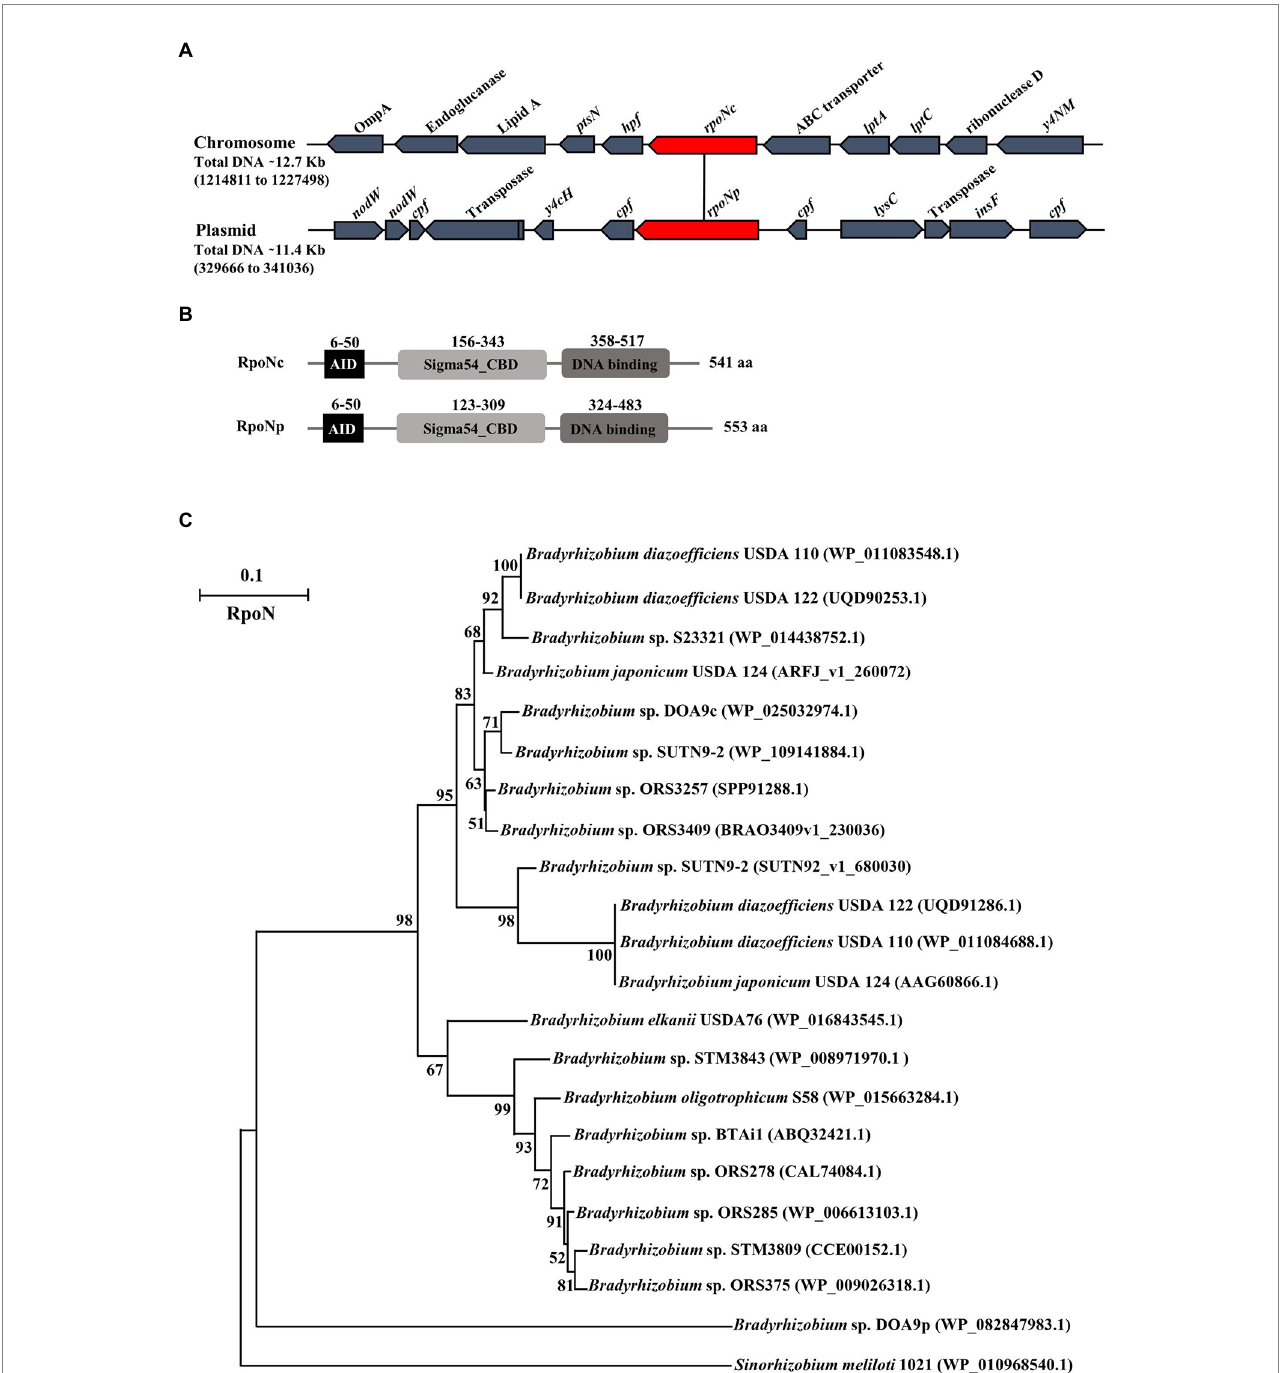
FIGURE 1 Diagram of the chromosomal and plasmid region containing rpoN in Bradyrhizobium sp. strain DOA9 (A) . Different protein domains present in chromosomal and plasmid encoded RpoN; AID (activator initiation domain), CBD (core binding domain), and DNA binding domain (B) . Phylogenetic analysis of RpoN from various Bradyrhizobium strains using the maximum-likelihood method with 1,000 bootstrap replicates. Sinorhizobium meliloti 1021 RpoN was used as outgroup protein (C)